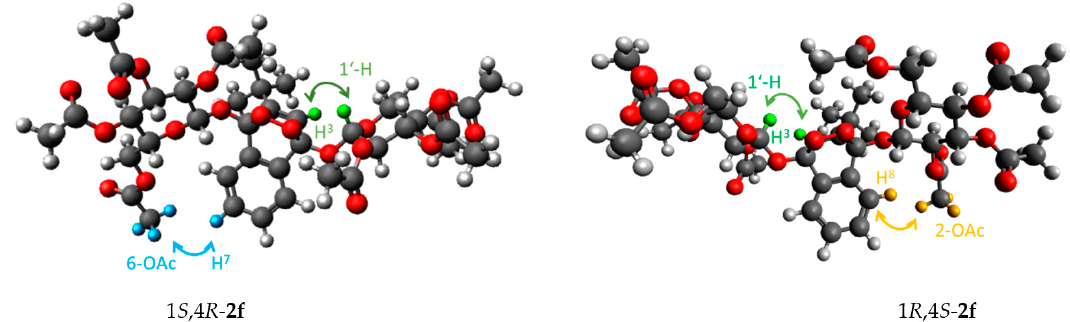
Figure 3. Calculated energetically minimized structures of EPOs 1 S ,4 R - 2f and 1 R ,4 S - 2f . Carbon atoms are marked black; oxygen atoms are marked red; hydrogen atoms are marked grey; blue, green, and yellow indicate the distinct NOE inter- actions (compare Figure 2).